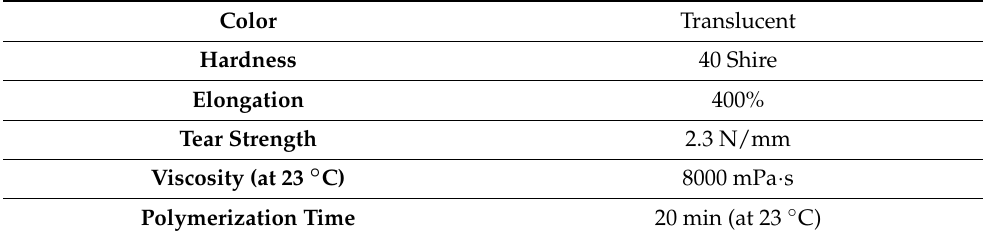
Table 1. SILBIONE RTV 4439 qualities (Reprinted from an open-access source) [138]. Color